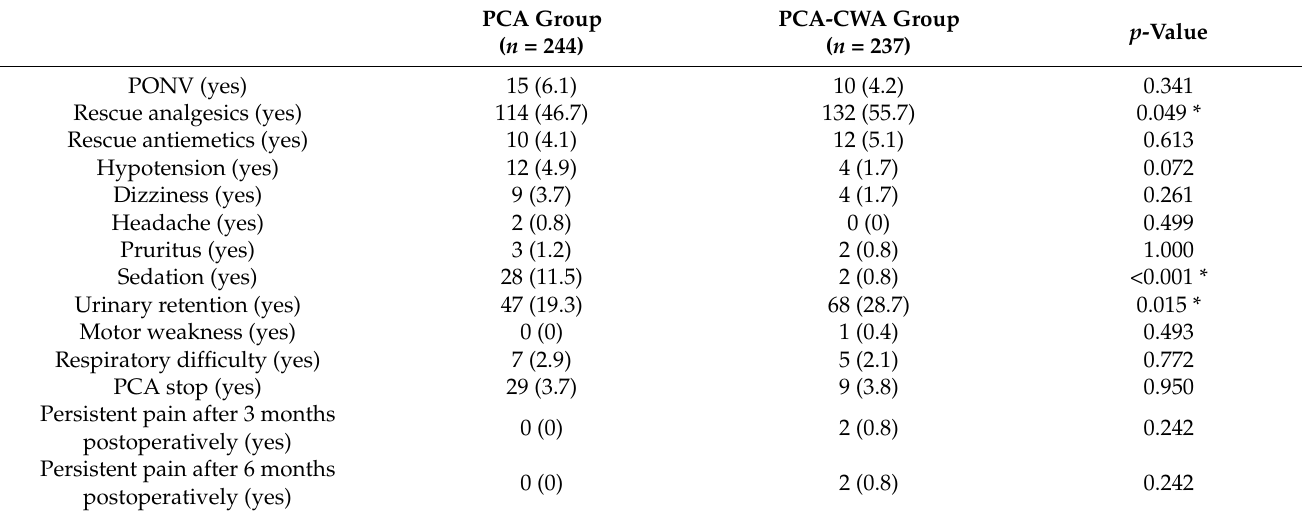
Table 5. Postoperative outcomes before propensity score matching.